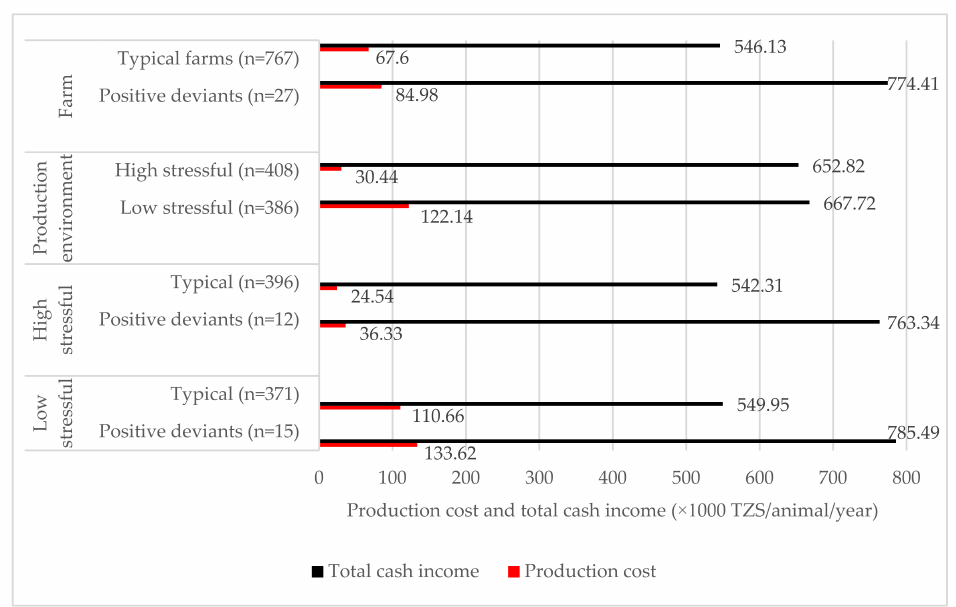
Figure 2. Total production cost and total cash income from dairy cattle on positive deviants and typical farms nested within production environment (Exchange rate 2297.5295 Tanzanian Shillings (TZS) = 1 US dollar).